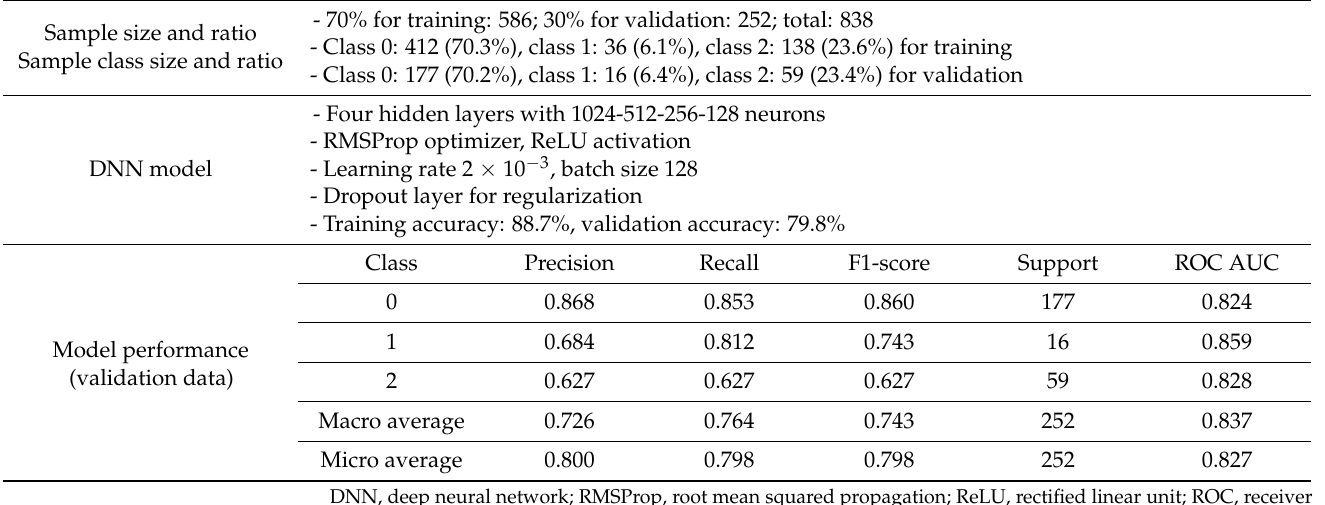
Table 6. Details of the model for determining the application of calcaneocuboid arch